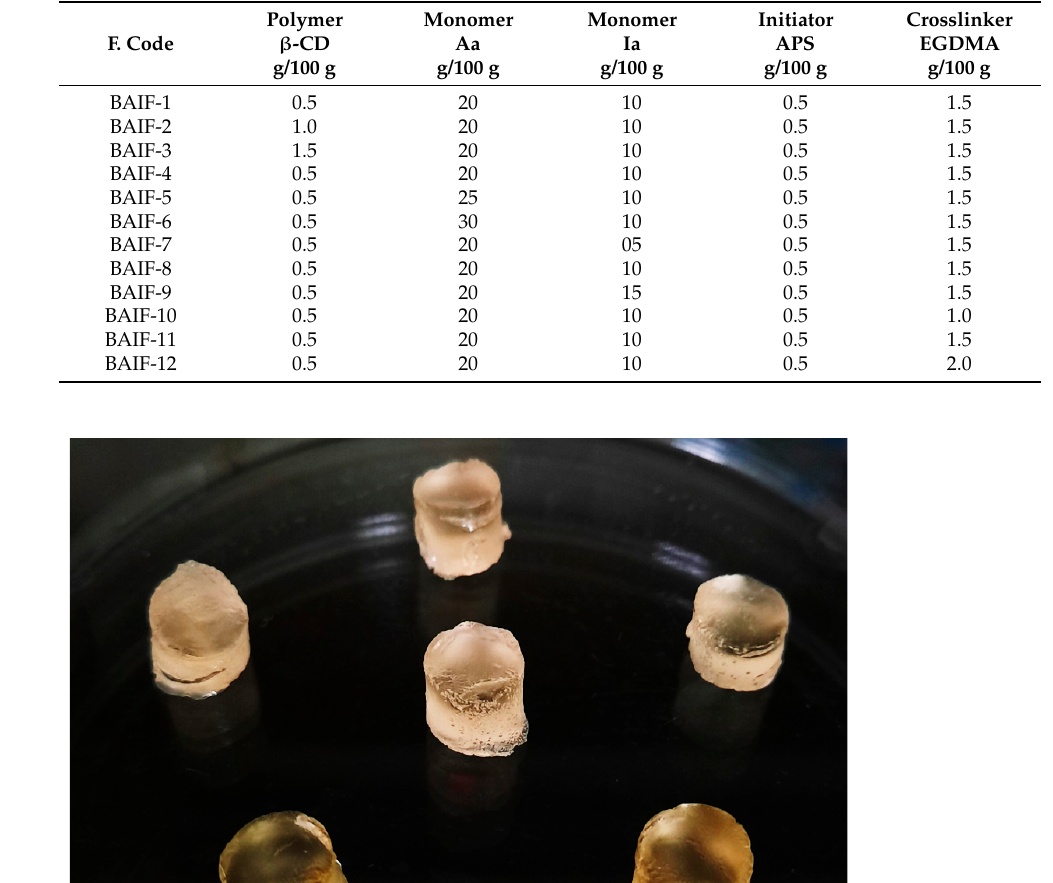
Table 1. Feed ratio scheme for the formulation of β -CD- g -P(Aa/Ia) hydrogels. F. Code